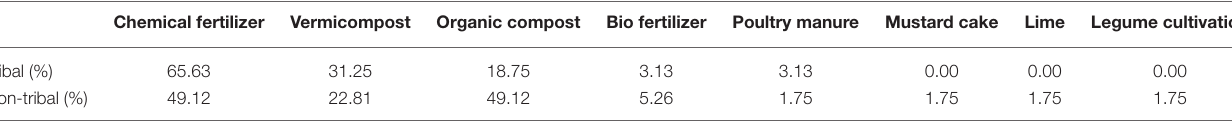
TABLE 6 | Farmer assessment of new practices to increase soil fertility (farmer-identified).